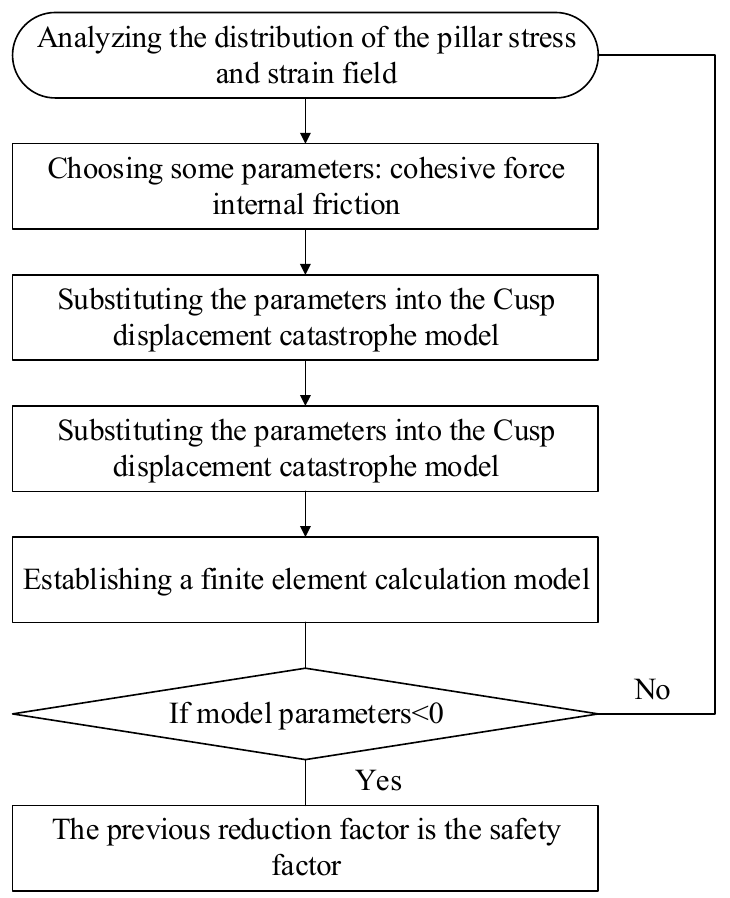
Figure 9. The realization process of cusp displacement catastrophe model in the judgment of pillar stability.